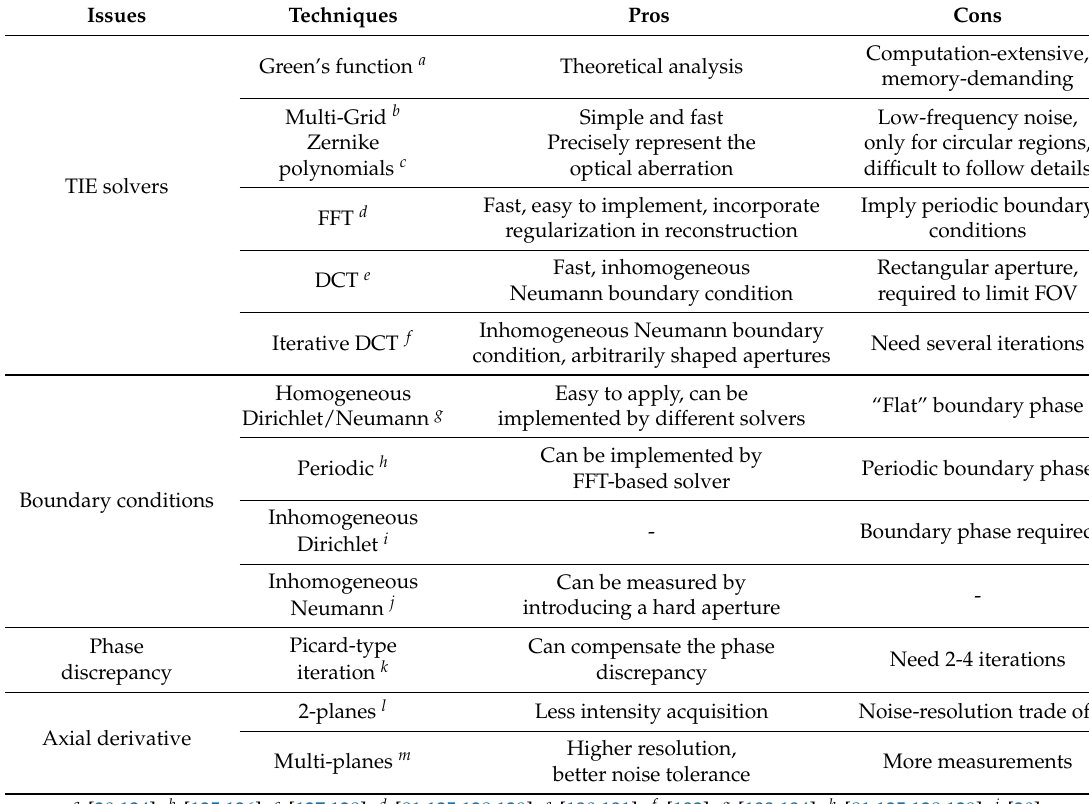
Table 3. Comparison of TIE